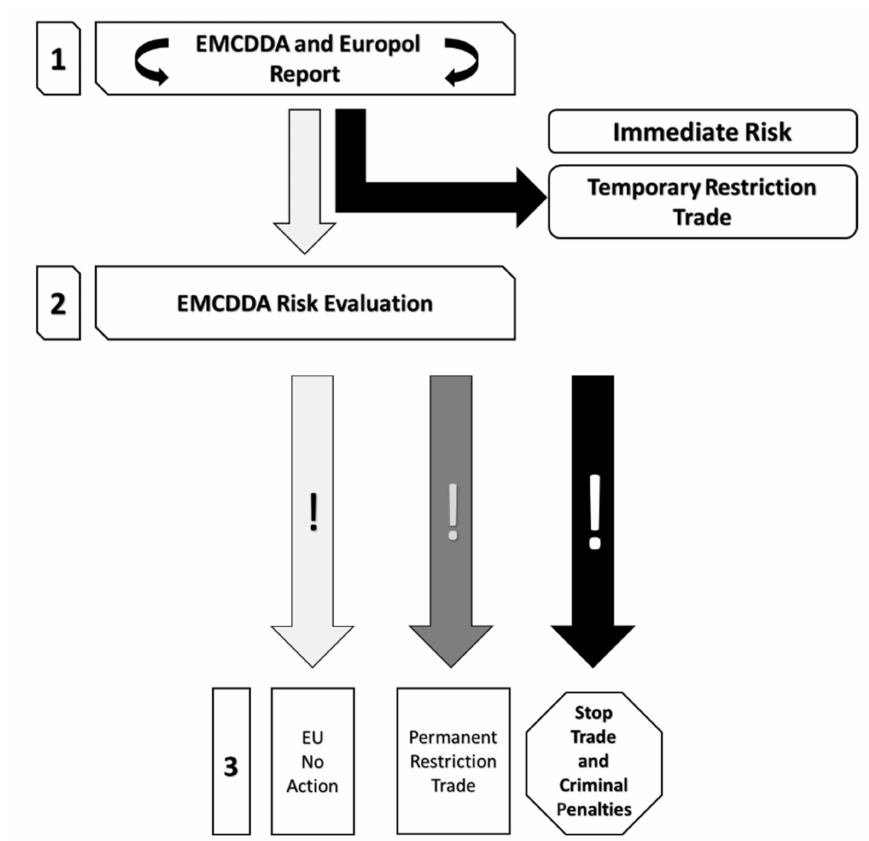
Figure 2. New procedure according to IP / 11 /